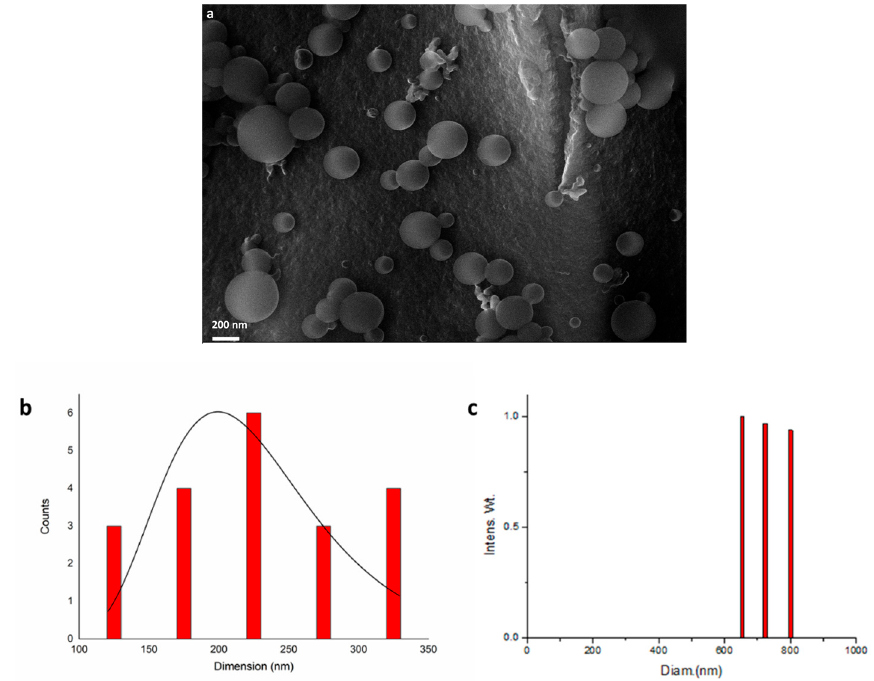
Figure 3. ( a ) SEM analysis of iridium nanoparticles recovered after entry 11, Table 2; ( b ) Size distribution of micellar structures; ( c ) DLS analysis at 654 nm.